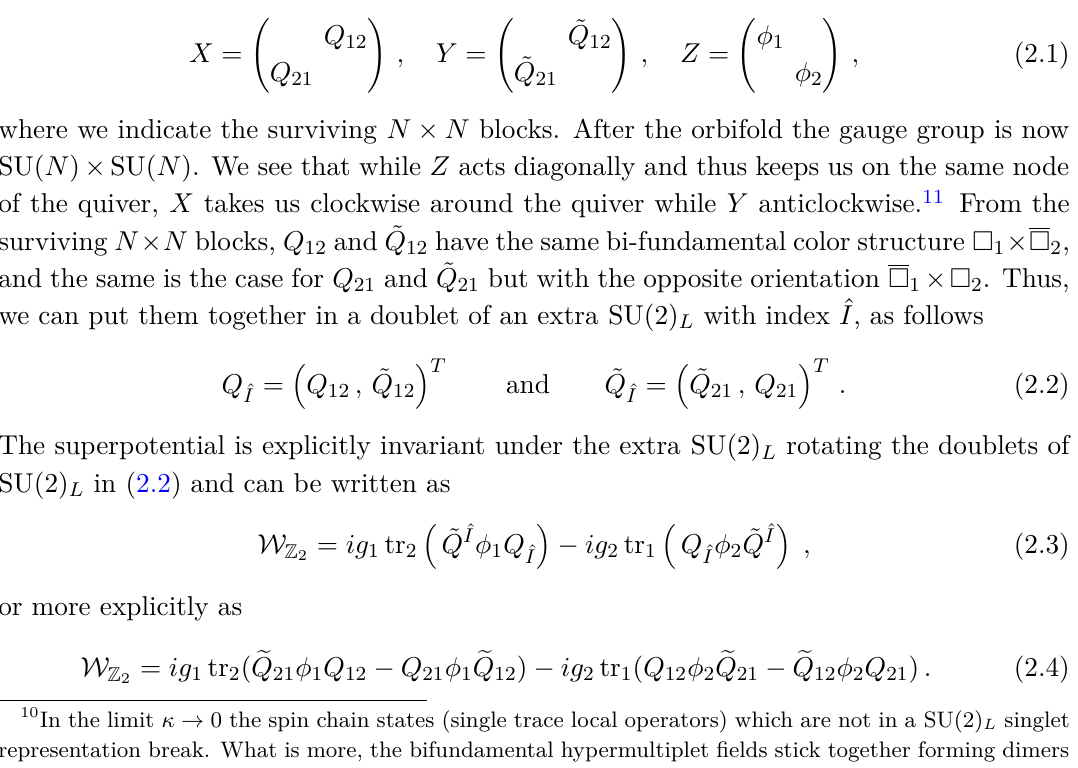
which combines with the extra SU(2) SCQCD [7].